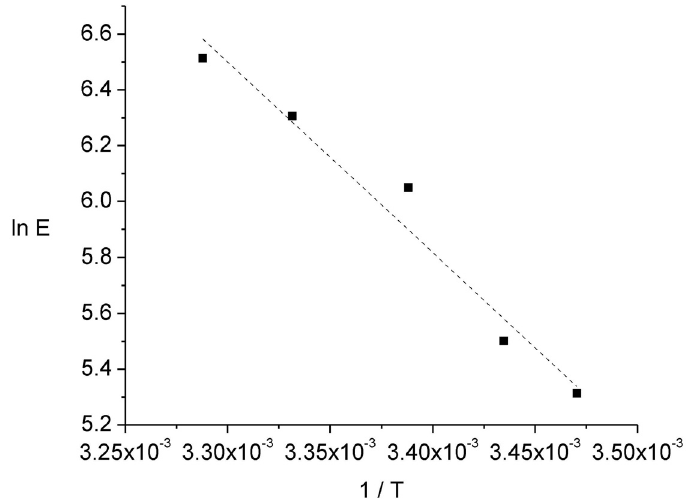
Figure 4. Arrhenius-type plot from which the activation energy of the permeation process, E , was evaluated. Donor phase: 6.7 × 10 − 6 mol L − 1 Ni(II), 0.01 mol L − 1 MES, pH 6.6; a acceptor phase: 0.01 mol L − 1 HCOOH, pH = 2; membrane phase: 0.012 mol L − 1 Kelex 100; 300 min of sampling